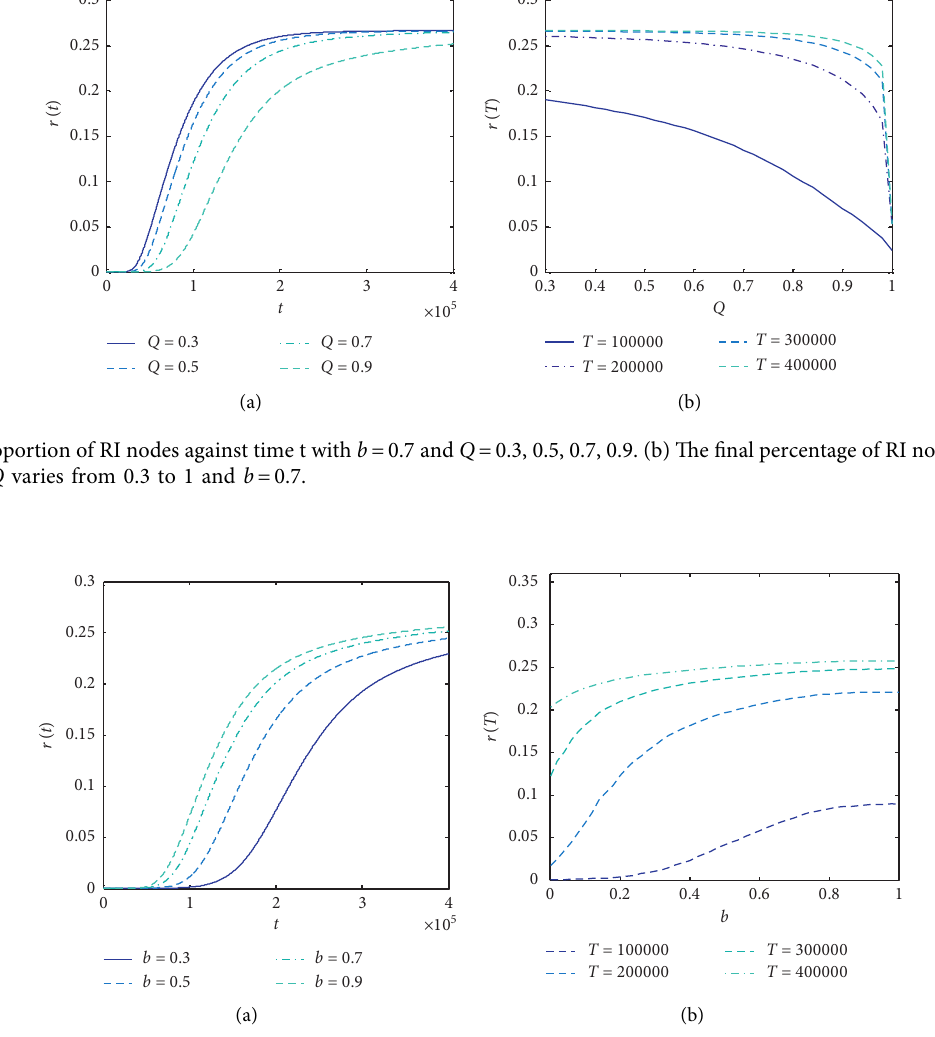
Figure 5: (a) Proportion of RI nodes with Q � 0.9 and b � 0.3, 0.5, 0.7, 0.9. Other settings are the same as the default settings. (b) The final proportion of RI nodes with b changing from 0 to 1 and T � 100000, 200000, 300000, 400000, respectively. Q � 0.9. Other settings are the same as the default settings.